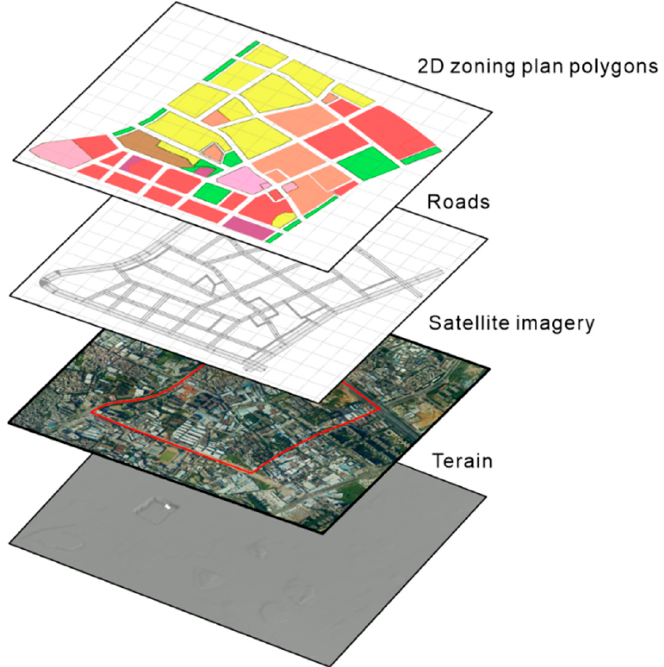
Figure 2. Dataset collected for the construction of urban models, including terrain with satellite imagery, road centerlines, and 2D zoning plan polygons.